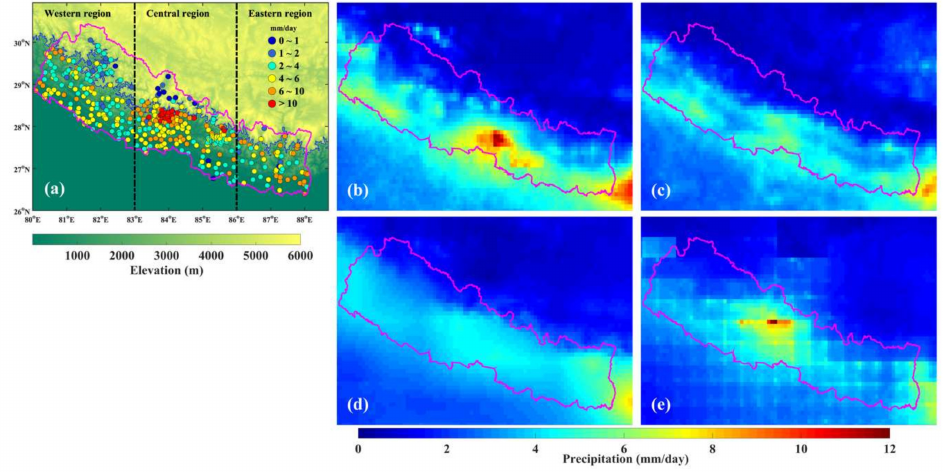
Figure 3. Spatial distribution of mean precipitation (mm / day) estimated by ( a ) observations, ( b ) IMERG-UC, ( c ) GSMaP-MVK, ( d ) IMERG-C and ( e ) GSMaP-Gauge averaged over March 2014 to December 2016. The magenta and black dotted lines represent the national boundary of the country and the three subregions, respectively.